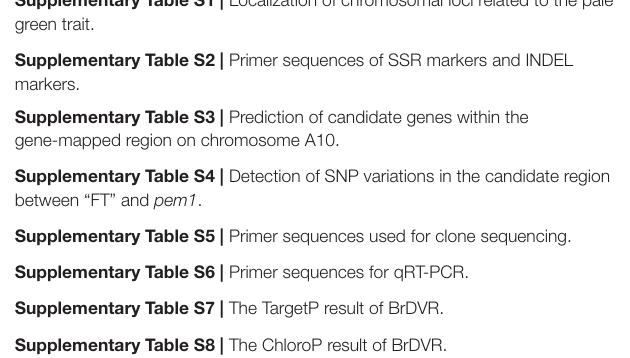
Supplementary Figure S4 | Protein sequence analysis of BrDVR and the phylogenetic tree of BrDVR and homologs.